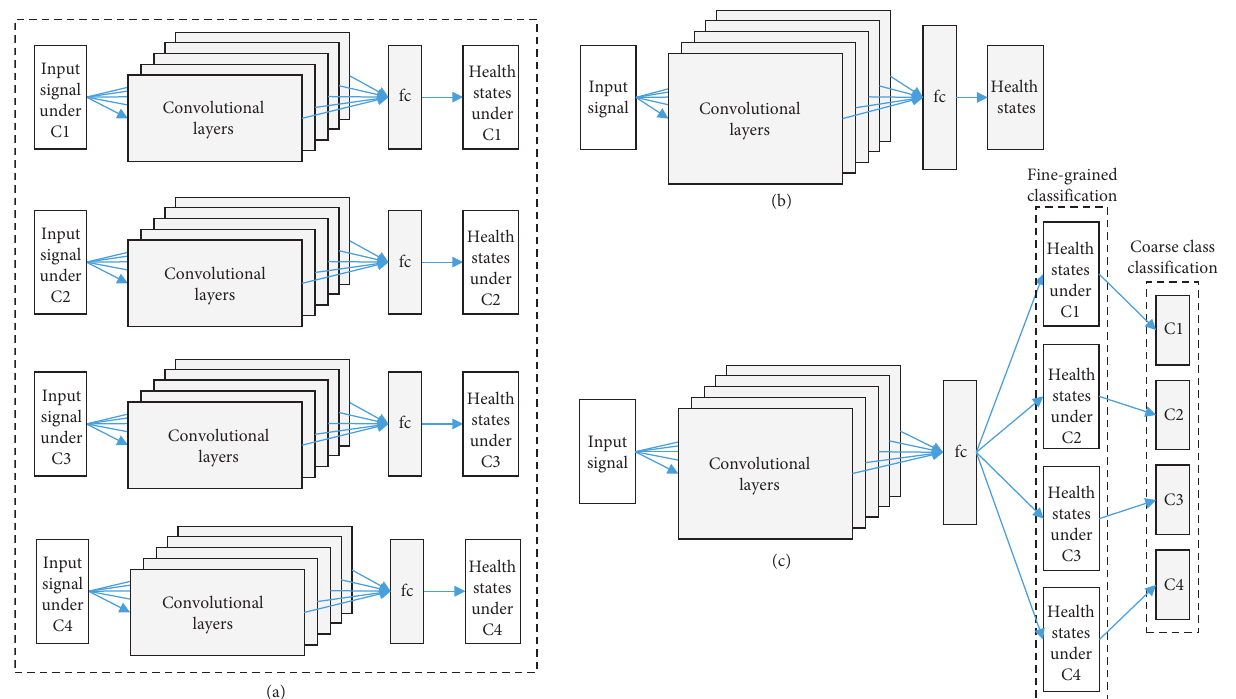
Figure 1: The comparison between the traditional CNN fault diagnosis method and the fine-grained fault diagnosis algorithm. (a, b) The framework of the traditional CNN methods. “fc” denotes the fully connected layer. “C1” ∼ “C4” denote 1 ∼ 4 gear position, respectively. (c) The fine-grained fault diagnosis algorithm with two-level hierarchy label structure.